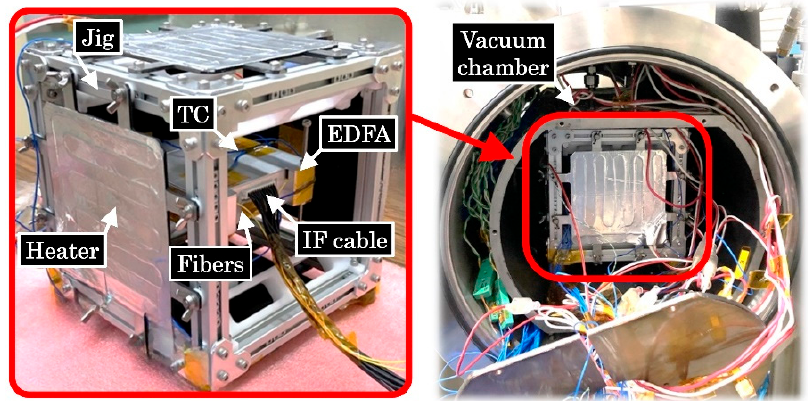
Figure 11. EDFA module inside a jig with the heaters and thermocouples for the thermal vacuum